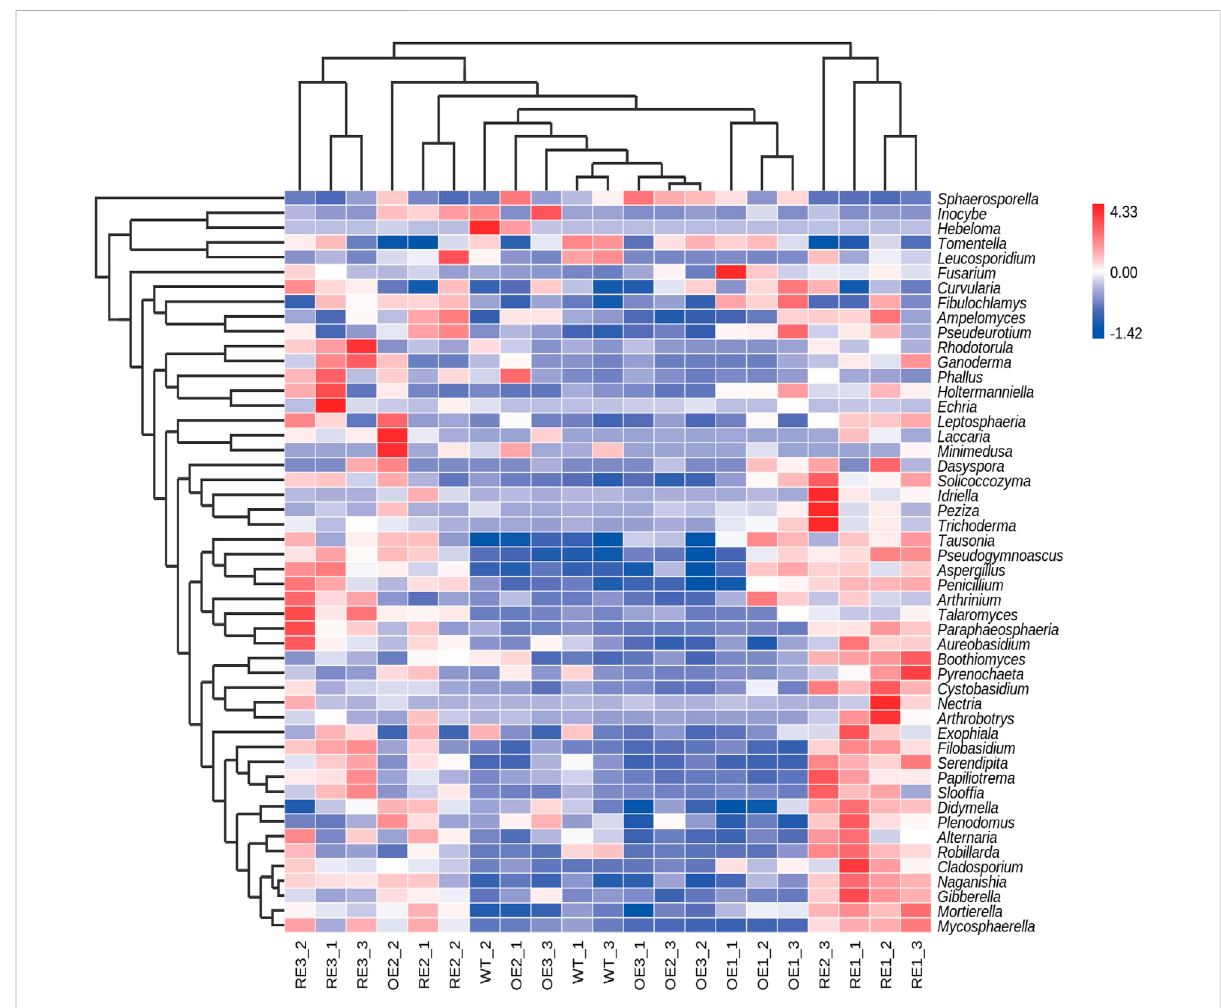
FIGURE 6 Abundance clustering heat map of the top 50 genera in rhizosphere soil fungal communities of the tested